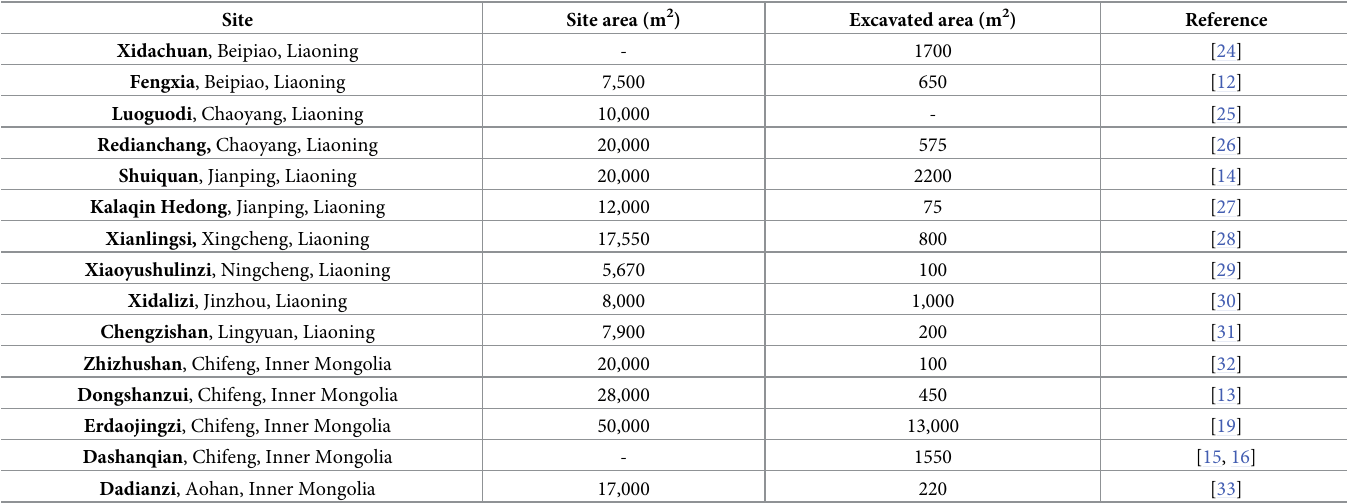
Table 1. Type A: Low-platform earthen sites.